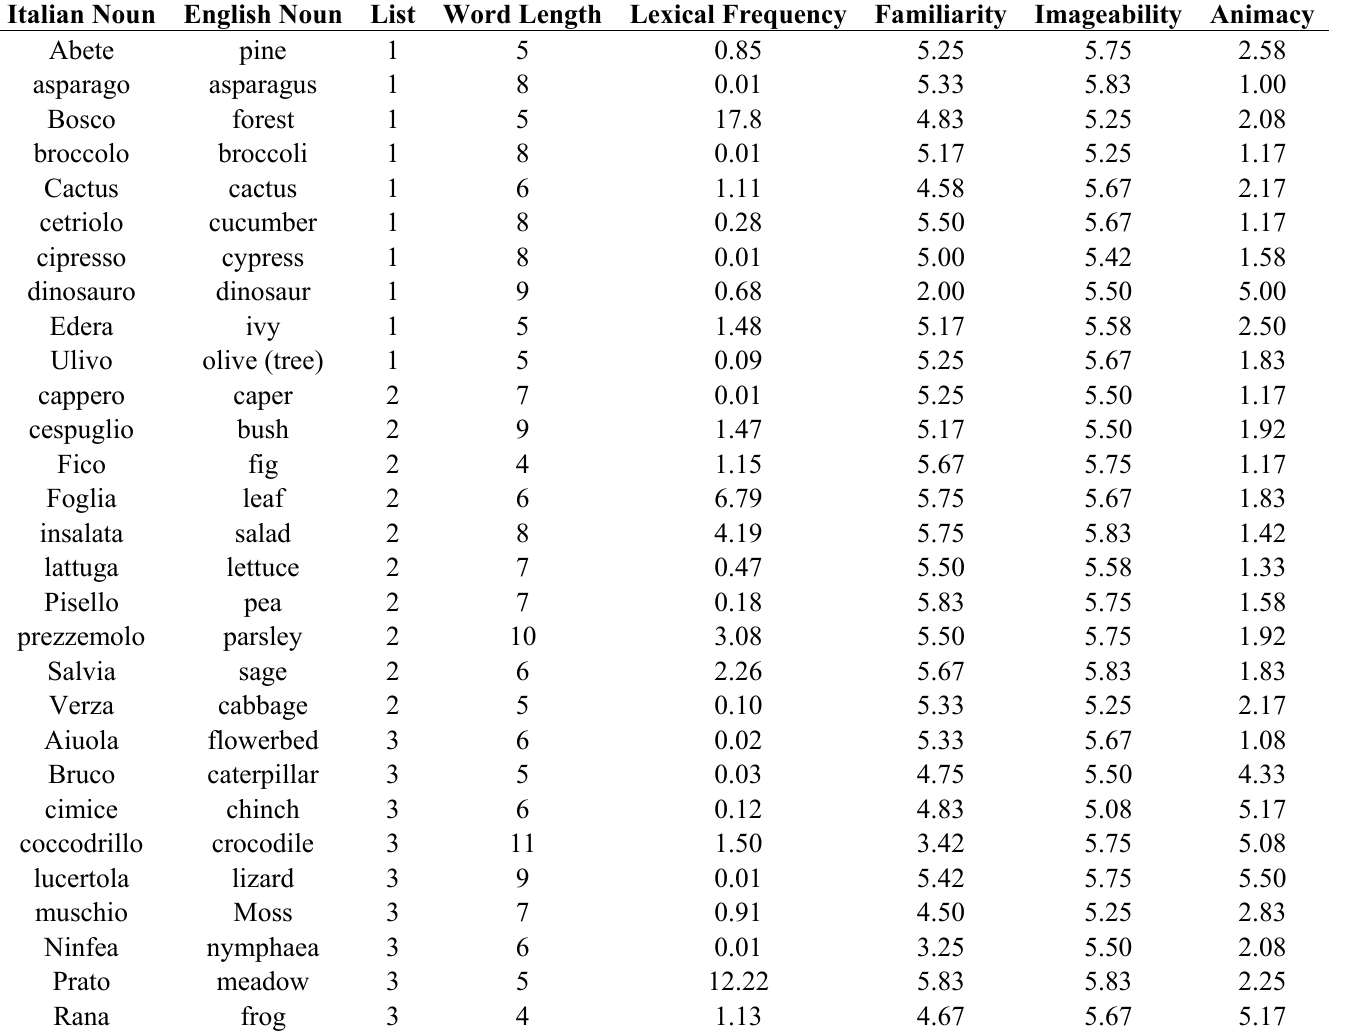
Table 1. Complete list of nouns used in Phase 2, their length (number of letters), lexical frequency (occurrences per million), familiarity (score on a seven-point scale), imageability (score on a seven-point scale), and animacy (score on a seven-point